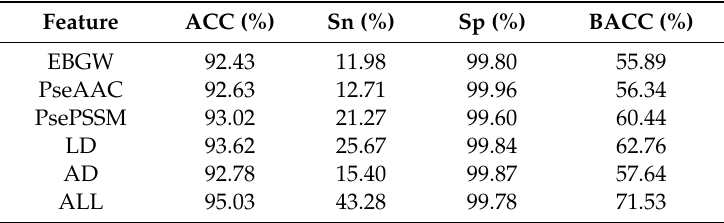
Table 6. Prediction results of di ff erent characteristics of the training dataset.